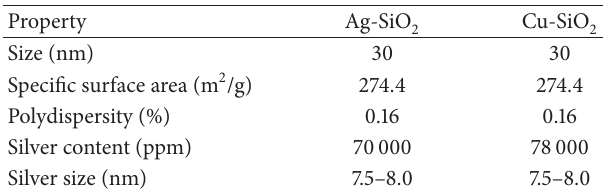
Table 1: Characteristics of nanosilica containing immobilized nanosilver or